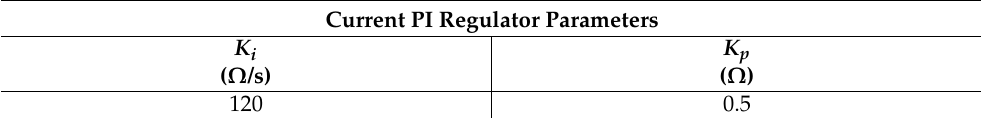
Table 3. Current PI regulator parameters.